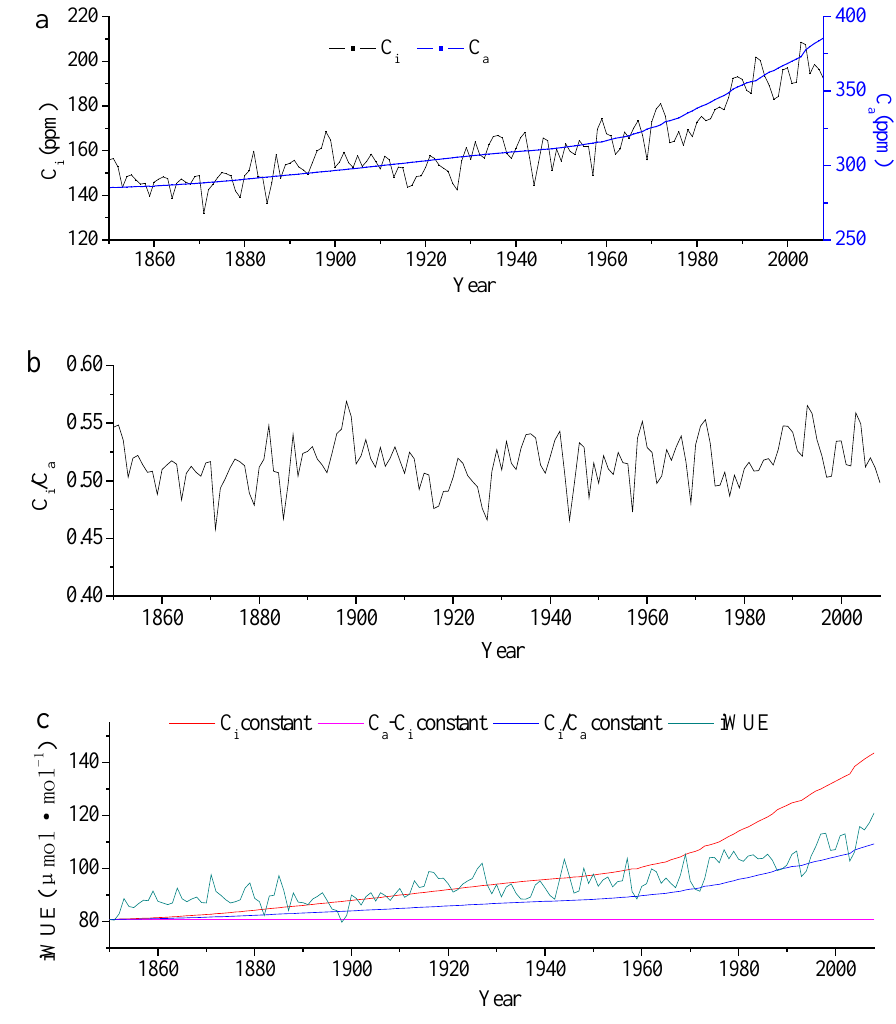
Figure 7. ( a ) Change in the leaf intercellular CO 2 concentration ( C i ) and ambient CO 2 concentration; ( b ) 13 C discrimination ratios ( C i / C a ); ( c ) intrinsic water-use efficiency (iWUE) calculated from three scenarios as a baseline for interpreting gas exchange in response to increasing C a over the past 160 years.